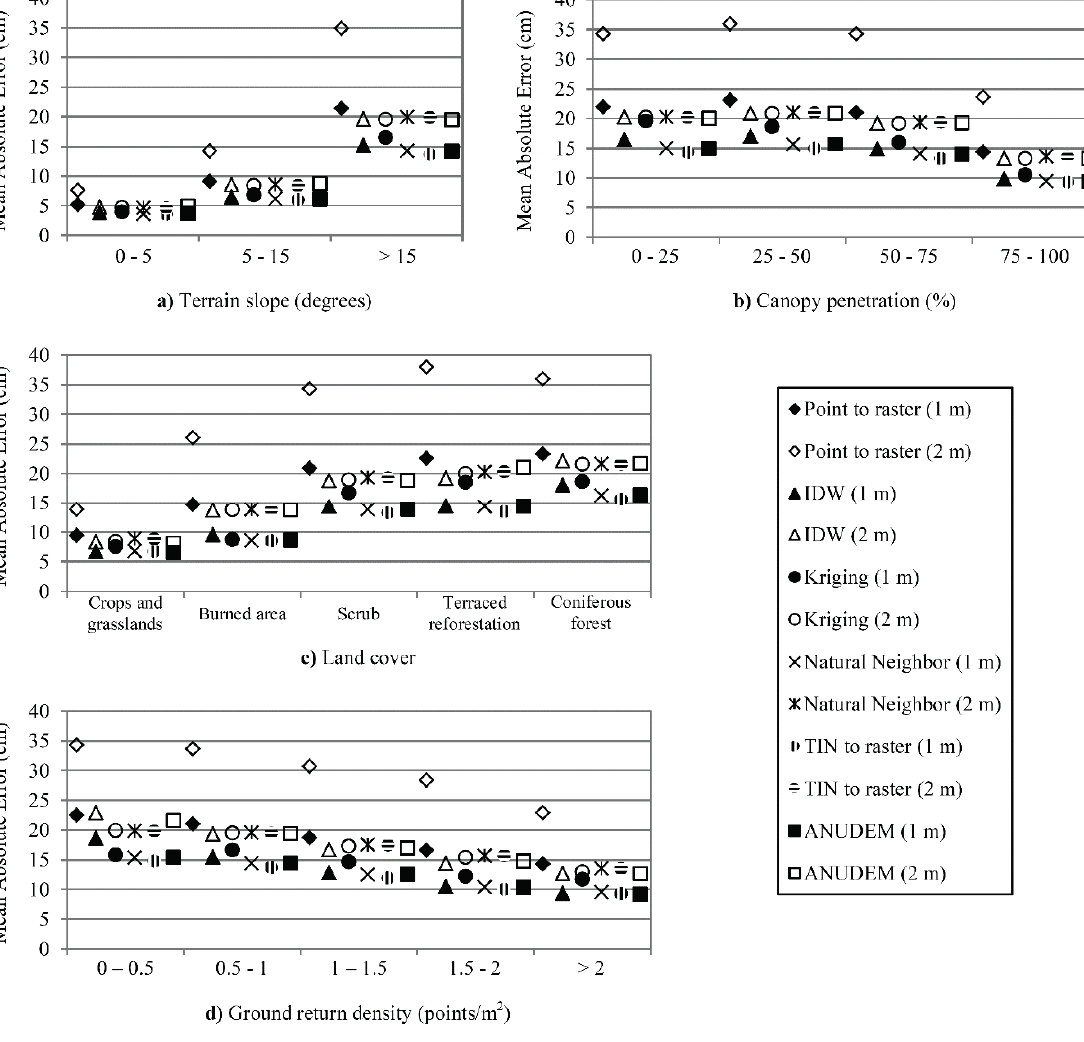
Figure 2. Effects of terrain slope ( a ); canopy pulse penetration ( b ); land cover ( c ) and ( d ) ground return density on MAE of